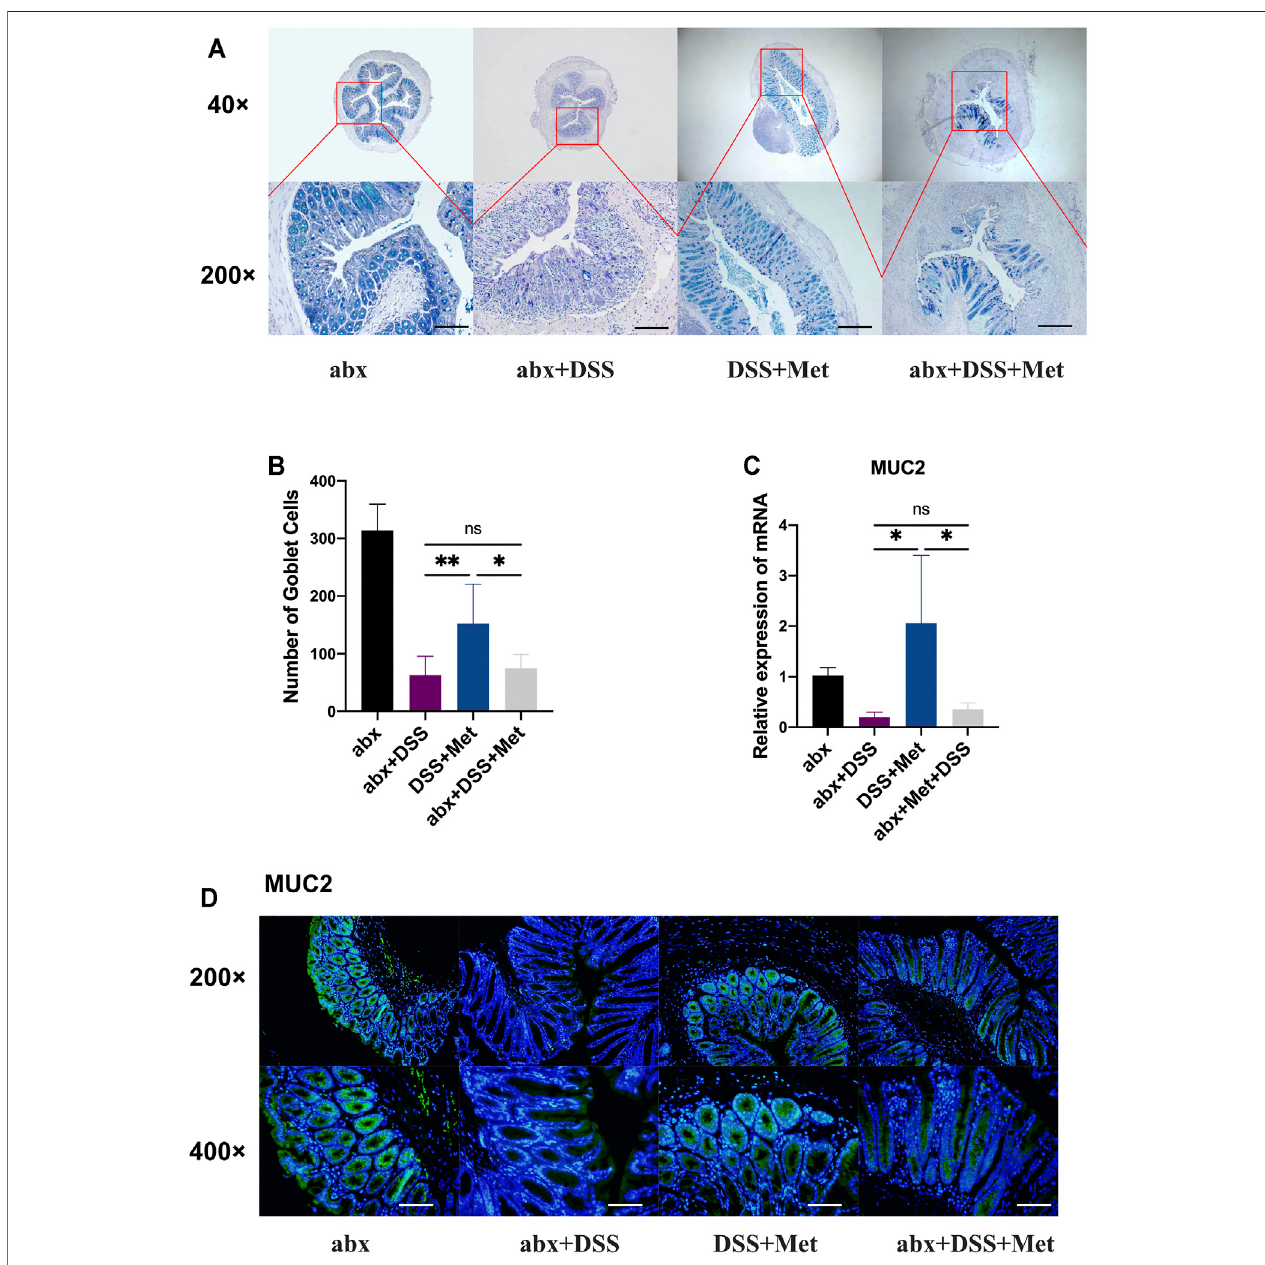
FIGURE 6 | Antibiotics abolish the mucus-protective effects of metformin. Alcian blue-periodic acid-Shiff (AB-PAS) staining (scale bars, 400 μ m) ( n (cid:1) 5 – 7) (A) and countofgobletcells( n (cid:1) 5 – 7) (B) ,relativeexpressionlevelsofmucin2(MUC2)( n (cid:1) 3 – 4) (C) ,andimmuno fl uorescenceassayofmucin2 proteininthemousecolon(scale bars, 200 μ m) ( n (cid:1) 3) (D) and statistical comparison was made using an ANOVA test followed by Dunnett ’ s post-hoc tests. * p < 0.05, ** p < 0.01, *** p < 0.001.